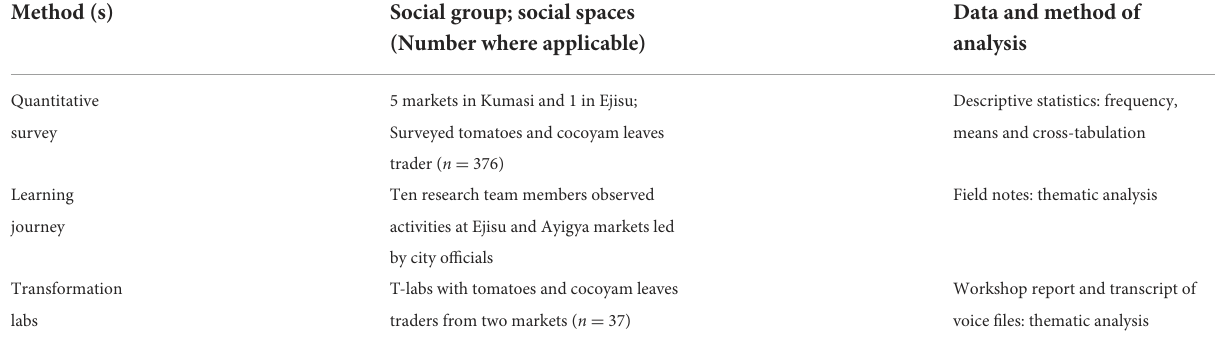
TABLE 1 Research methods and target social groups and social spaces. Method